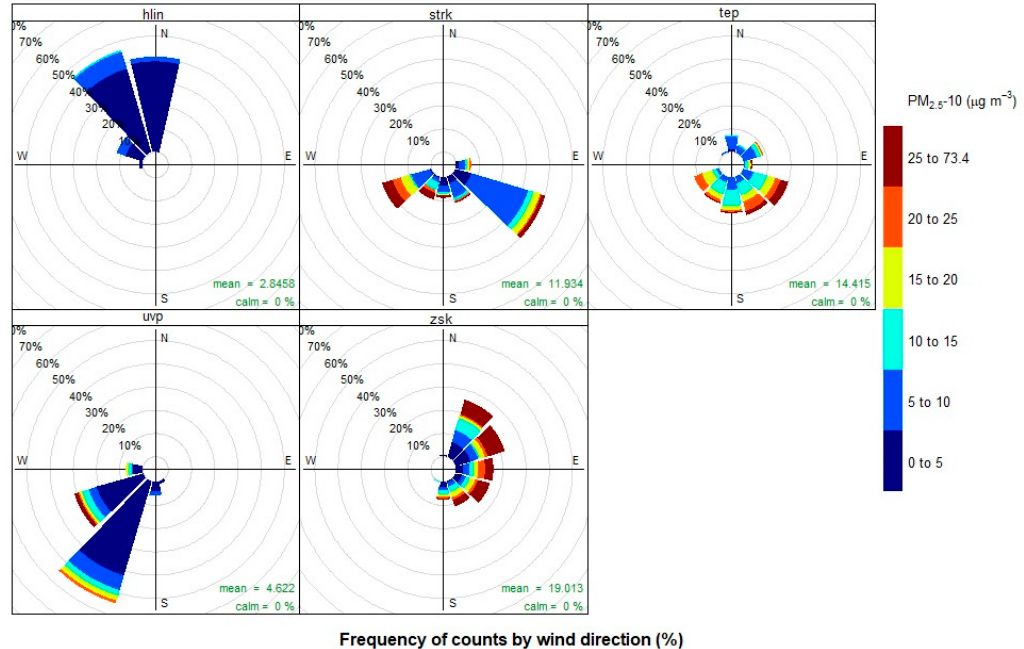
Figure 4. Pollution rose for PM 2.5-10 (course fraction) during measurements in Zilina City at different measurement stations.